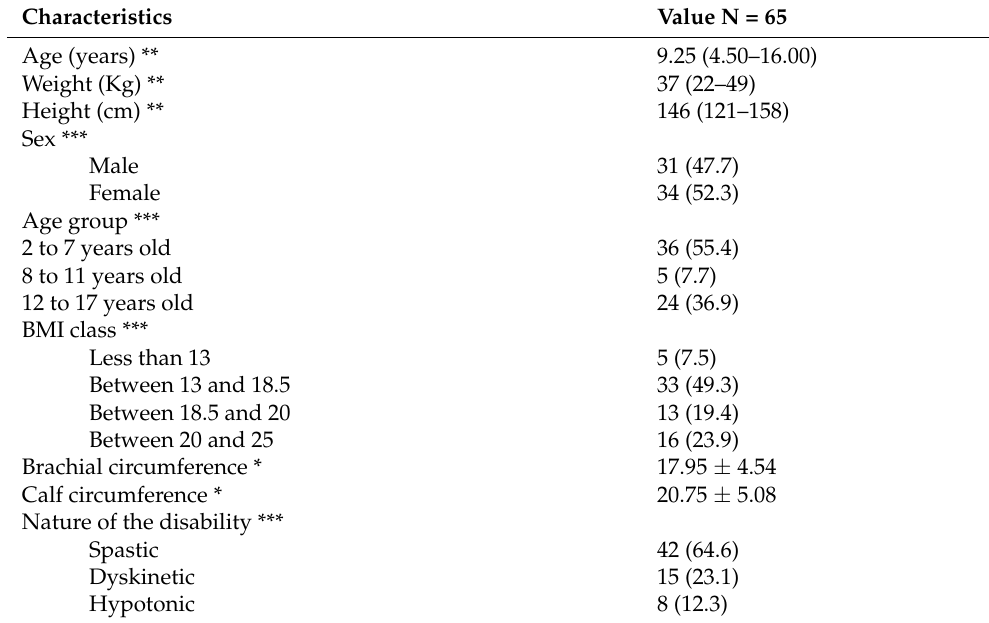
Table 1. Sociodemographic and clinical data of patients.